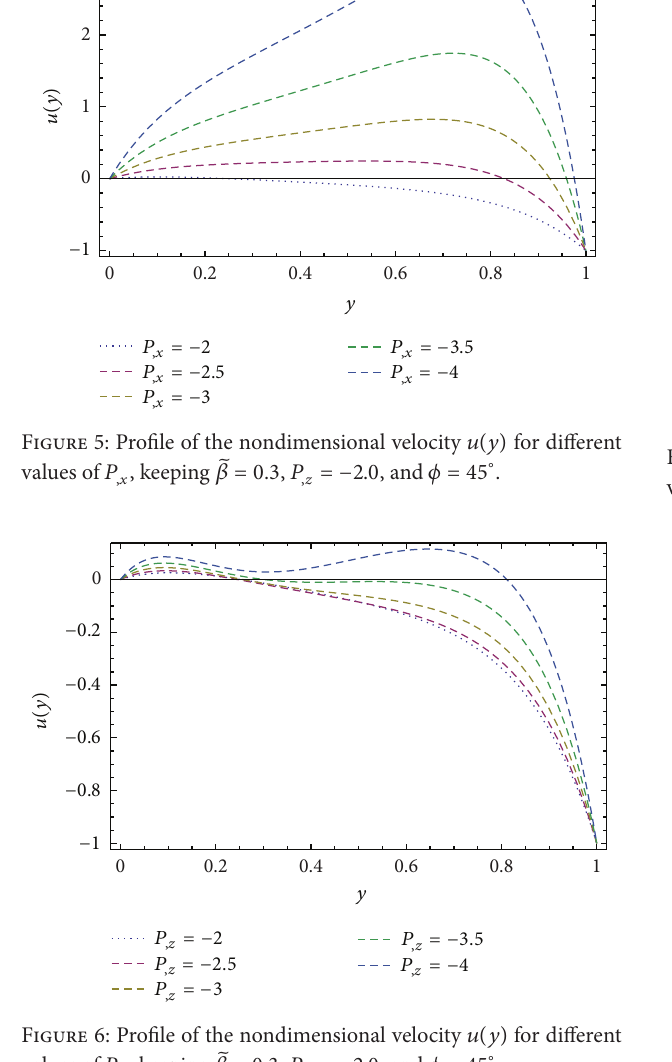
Figure 8: Profile of the nondimensional velocity 𝑤(𝑦) for different ̃𝛽 = 0.3 , 𝑃 ,𝑥 = −2.0 , and 𝜙 = 45 ∘ values of 𝑃 ,𝑧 , keeping